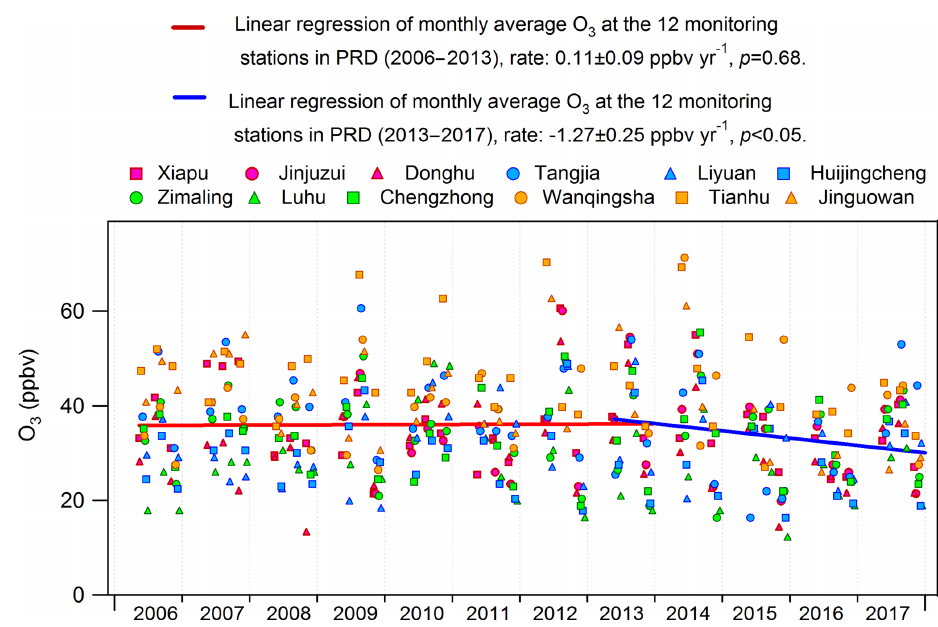
Figure 5. Trends of the observed monthly average O 3 at the 12 air quality monitoring stations in inland